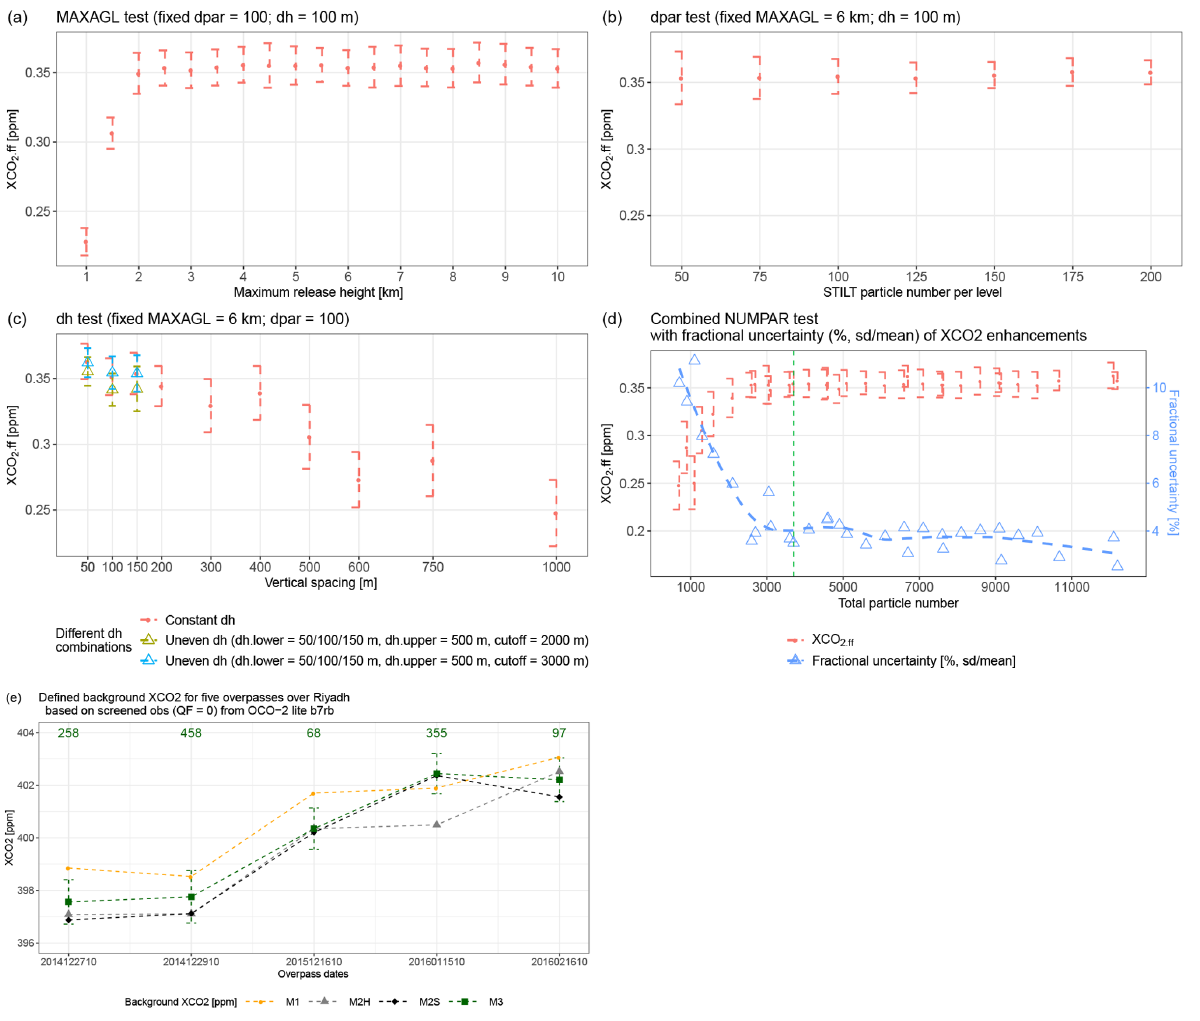
Figure 6. Results of sensitivity tests for one sounding (a–d) and background comparisons for five tracks (e) over Riyadh. The random error for each simulation is indicated using dashed red error bars (a–d) ; potential biases are shown as the trend of the mean XCO 2 enhancements (red dots; a–d ) derived from 100 bootstraps. (c) Vertical spacing tests include several tests with constant dh (red dots and error bars) and two tests with uneven dh above/below the cutoff level. The two uneven dh tests both use three different lower dh (50, 100, and 150m) and a fixed upper dh of 500m, but with two different cutoff levels, i.e., 2km (yellow-green triangles and error bars) and 3km (blue triangles and error bars). (d) A summary plot of the mean and SD of the XCO 2 enhancements (red dots and dashed red error bars) and fractional uncertainties (%; blue triangles and dashed line) as functions of total particle number (NUMPAR). The green dashed vertical line denotes the configuration used in this study. (e) Background comparisons using different methods (M1, M2H, M2S, and M3) for five tracks. The number of screened observations used for M3 background is noted in dark green. M3 background errors (including spatial variation and retrieval errors over the background region) are indicated as dashed green error